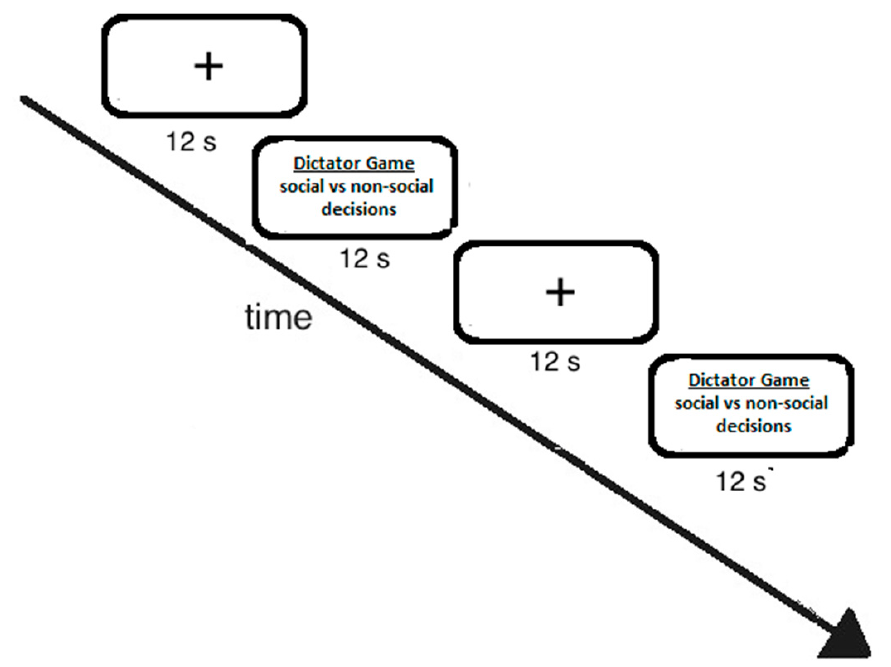
Figure 1. Experimental design. See text for further details.